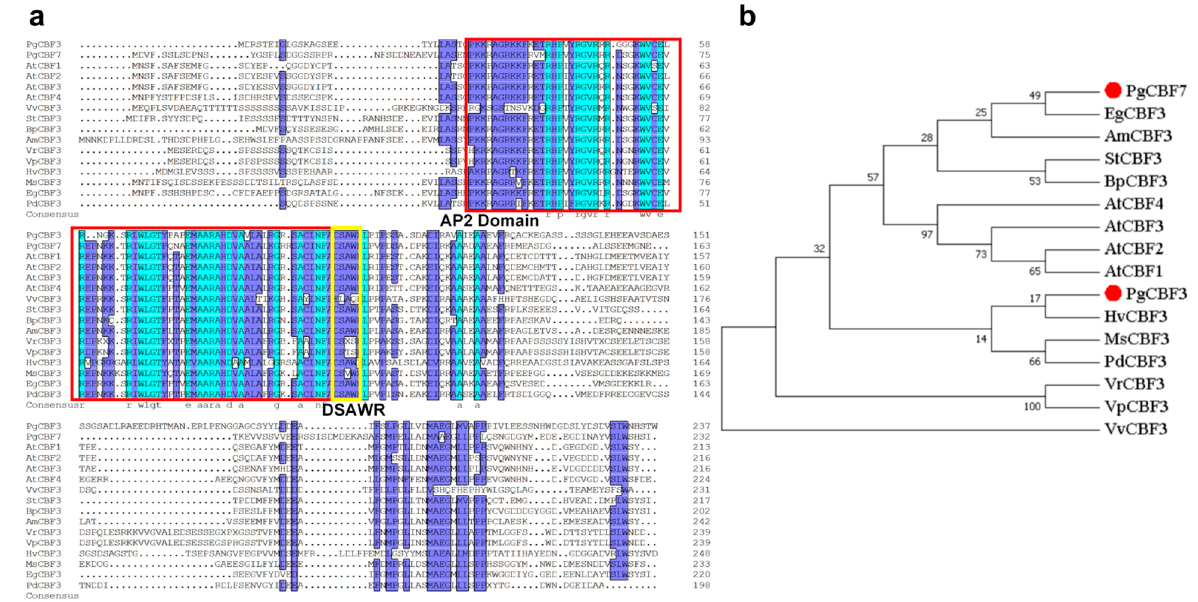
Figure 2. Alignment and phylogenetic analysis of PgCBF3 and PgCBF7 protein with other CBF proteins. ( a ) Sequence alignment of PgCBF3 and PgCBF7 protein with the other CBF proteins from other plant species; ( b ) Phylogenetic tree of CBF proteins from different species. AtCBF1 (AT4G25490.1); AtCBF2 (AT4G25470.1); AtCBF3 (AT4G25480.1); AtCBF4 (AT5G51990.1); BpCBF3